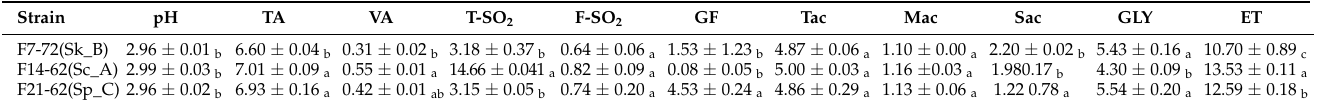
TA: total acidity (g/L of tartaric acid). VA: volatile acidity (g/L of acetic acid). T-SO 2 : total SO 2 (mg/L). F-SO 2 : Free SO 2 (mg/L). GF: glucose plus fructose (g/L). Tac: tartaric acid (g/L). Mac: malic acid (g/L). Sac: succinic acid (g/L). Gly: glycerol (g/L). ET: ethanol (%, v/v